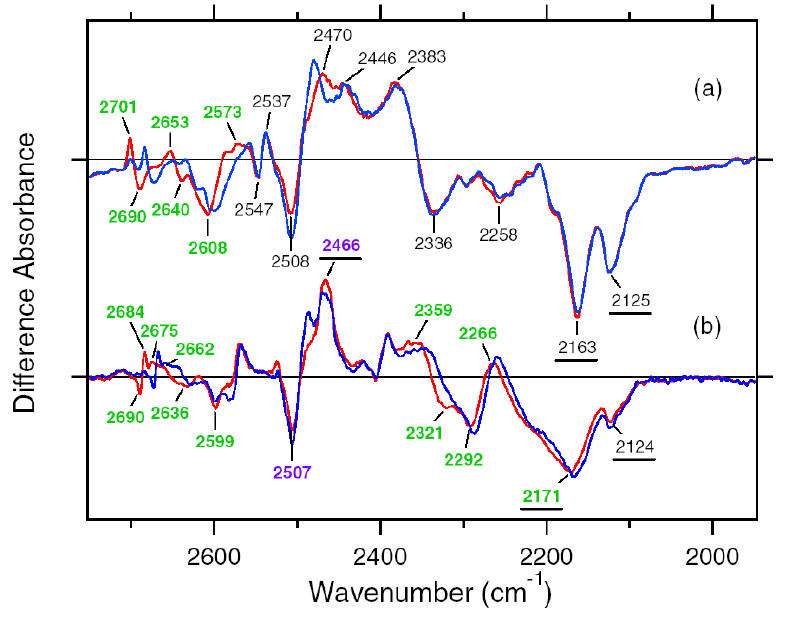
Figure 11. Comparison of the difference infrared spectra of ASR (a) and BR (b) hydrated with D O (red lines) or D 218 O (blue lines) in the 2,730-1,950 cm -1 region. Green-labeled 2 frequencies correspond to those identified as water stretching vibrations. Purple-labeled frequencies are O-D stretches of Thr89 [48,49], while the underlined frequencies are N-D stretches of the Schiff base [41]. Spectrum in (b) is reproduced from Tanimoto et al . [26], where the sample window is tilted by 53.5 o . One division of the y-axis corresponds to 0.0007 absorbance units. This figure is reprinted with permission from Furutani et